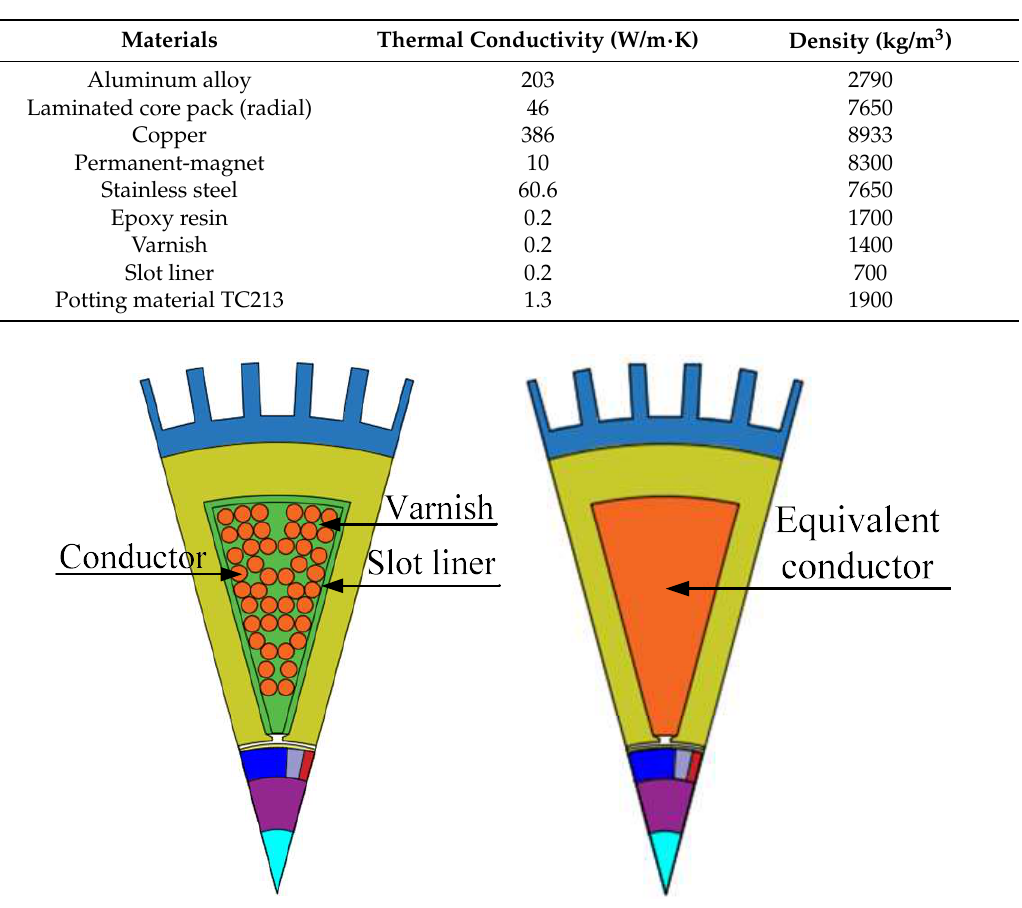
Table 4 . Physical properties of the motor Table 4. Physical properties of the motor materials.